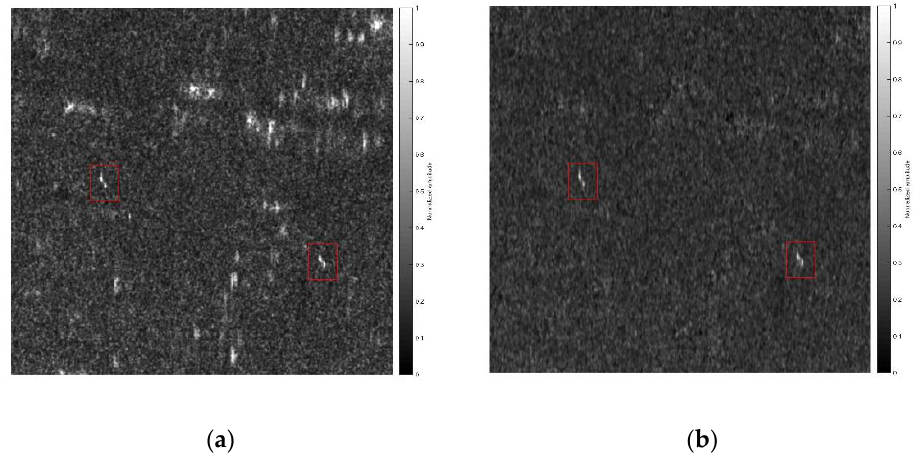
Figure 9. Comparison between ( a ) the original SLC image and ( b ) the processed result over a 900 × 900 m sub-area. Ships tracked by AIS are denoted by red squares.